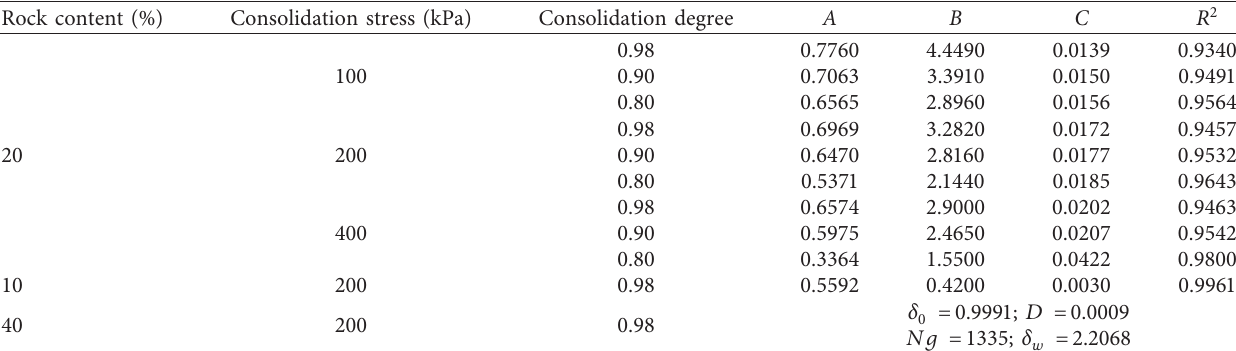
Table 4: Fitting parameters of the stiffness softening